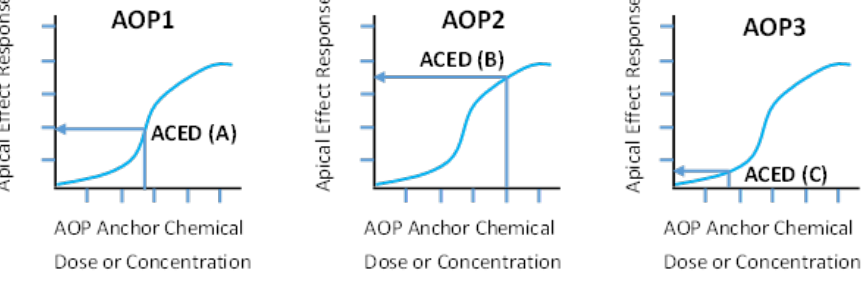
Figure 3. Hypothetical apical effect dose–response curves for AOP anchor chemicals A–C. Under step 6 of the AOP footprinting approach, under an assumption of independence (i.e., response addition), apical effect responses associated with each individual anchor chemical’s ACED across operant AOPs may be summed to estimate the total response associated with exposure to the mixture.